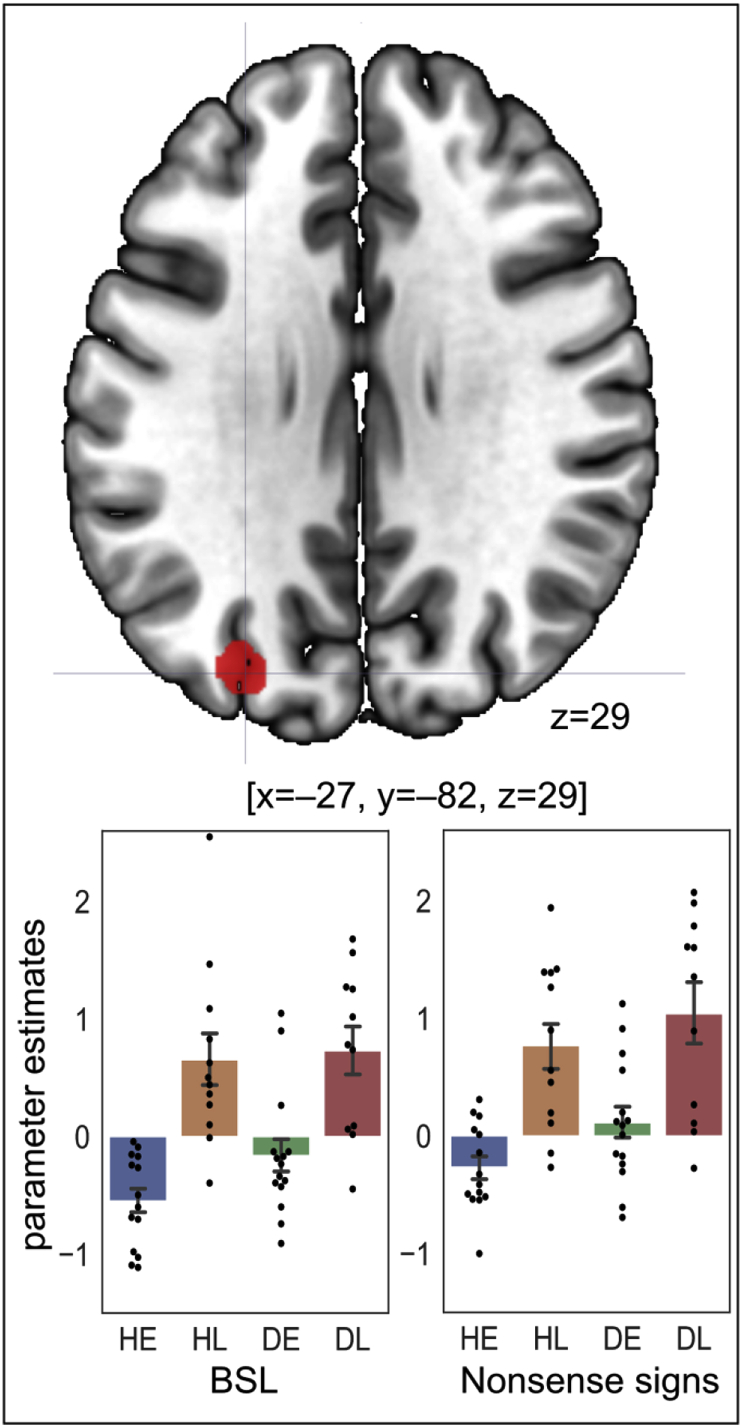
The main effect of age of BSL acquisition (late ​> ​early) in deaf and hearing signers. Top row: the effect is shown at p ​< ​.001 uncorrected. This effect was centred on the left paroccipital segment (the occipital end) of the intraparietal sulcus (Petrides, 2011). The crosshair indicates the peak coordinate at [x ​= ​−27, y ​= ​−82, z ​= ​29]. Bottom row: bar plots showing the parameter estimates at this peak for BSL on the left, nonsense sign strings on the right. Each data point is also displayed as a black dot. Error bars indicate standard errors.